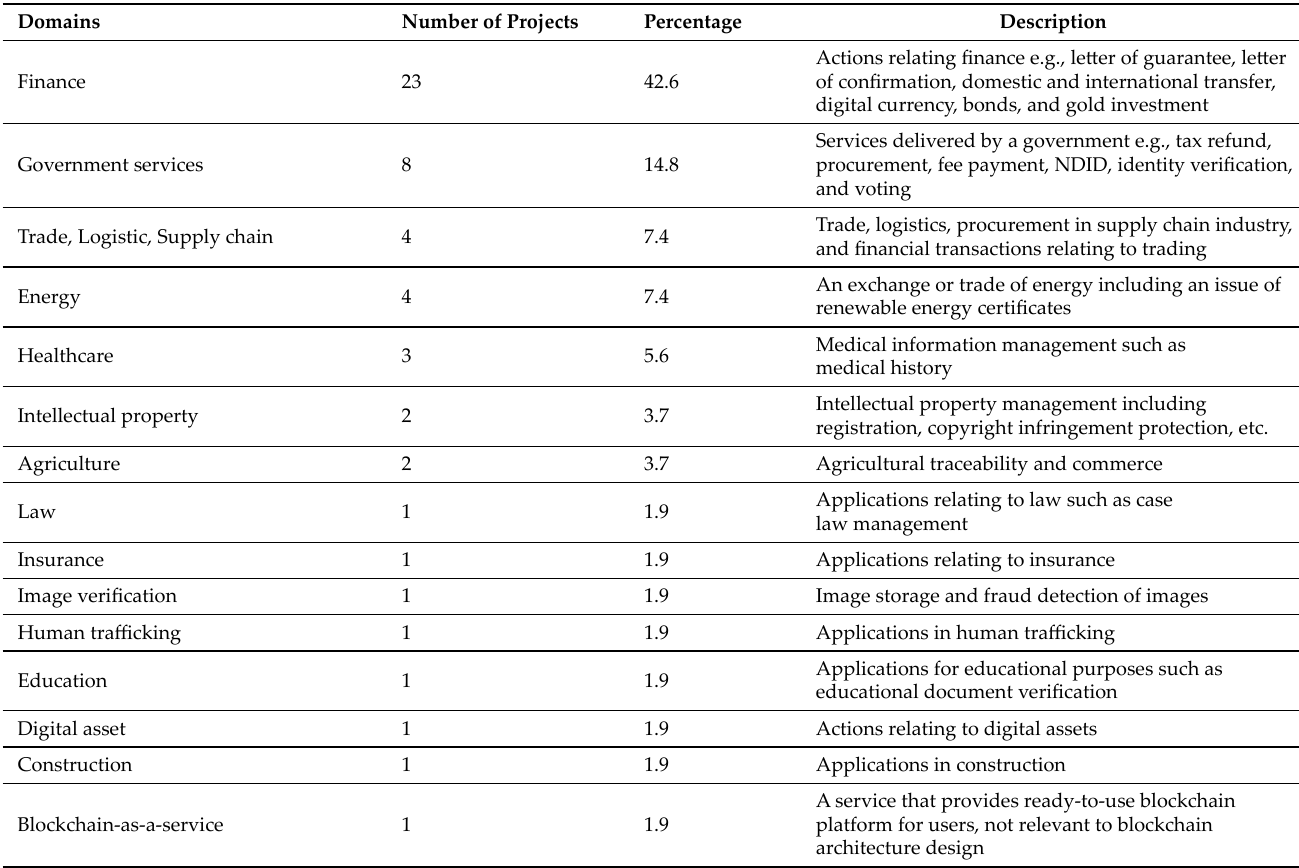
Table 5. A table explaining domain